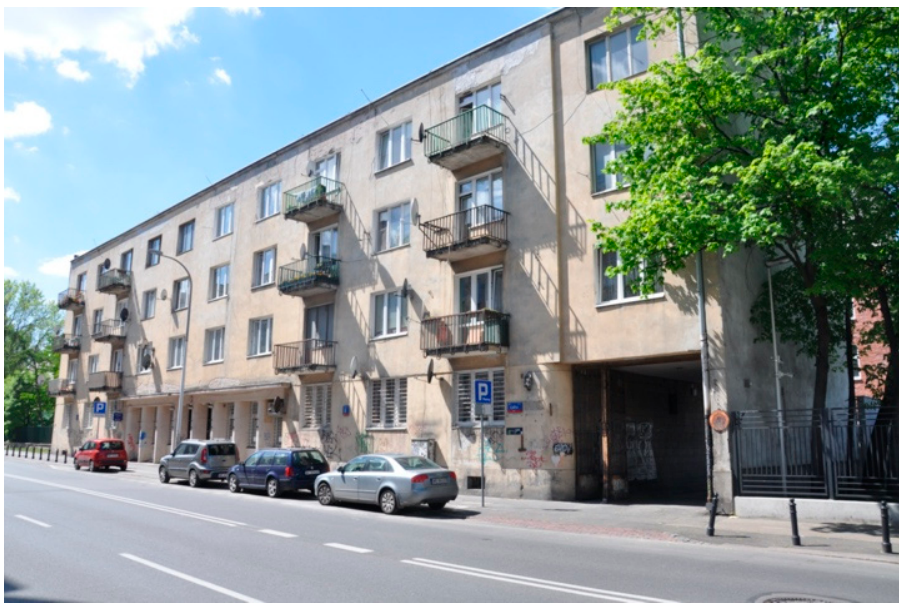
Figure 5. Building at 4 Ludna Street.